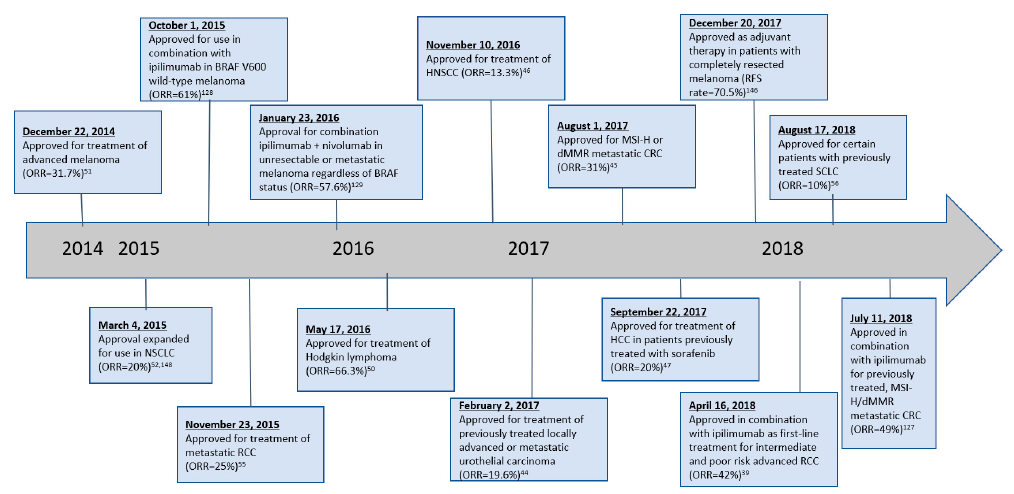
Figure 3. Timeline of nivolumab FDA approvals.